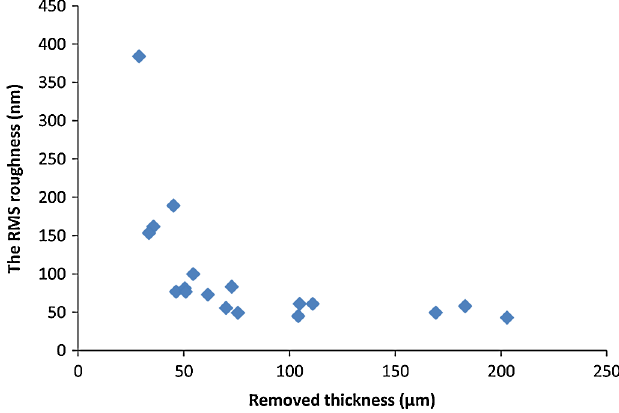
FIG. 8. (Color) Relationship between the roughness and re- moved